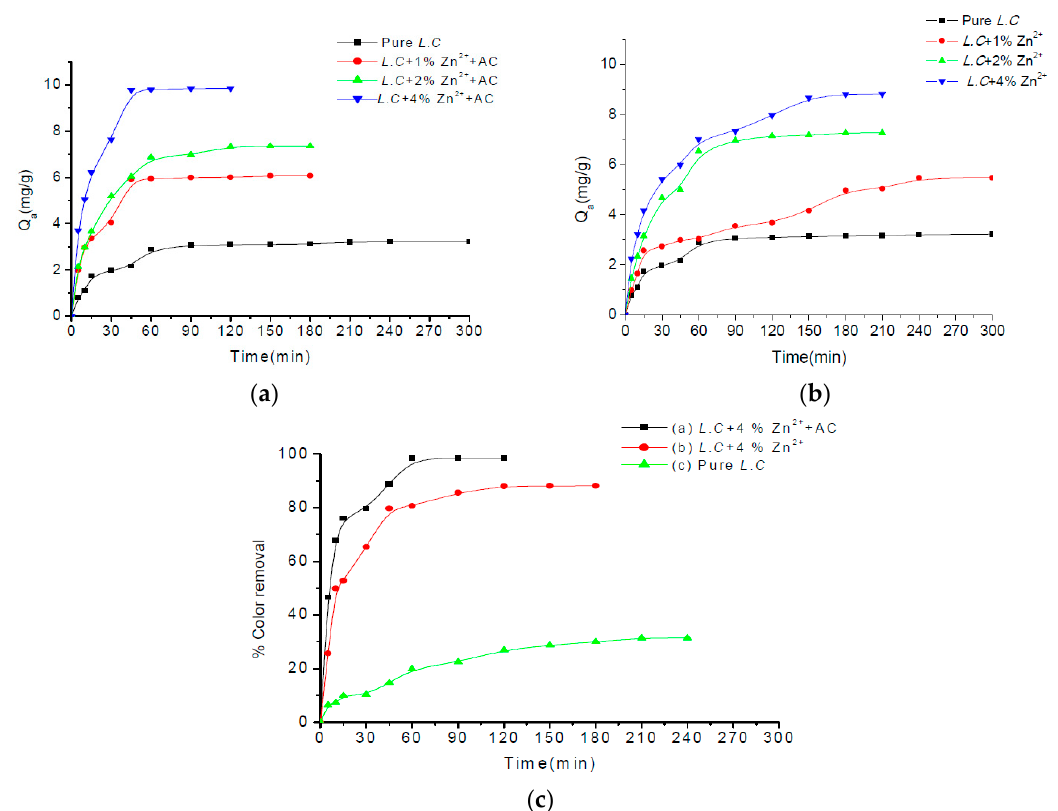
Figure 4. Kinetics of retention of methylene blue (MB) onto different materials used L.C ; pH = 10, C i = 10 mg/L, m = 0.1 g, T = 298 K. ( a ) hybrid material L.C + 4% Zn 2+ synthesized in presence of AC, ( b ) hybrid material L.C + 4% Zn 2+ synthesized in absence of AC, ( c ) % color removal using different materials.